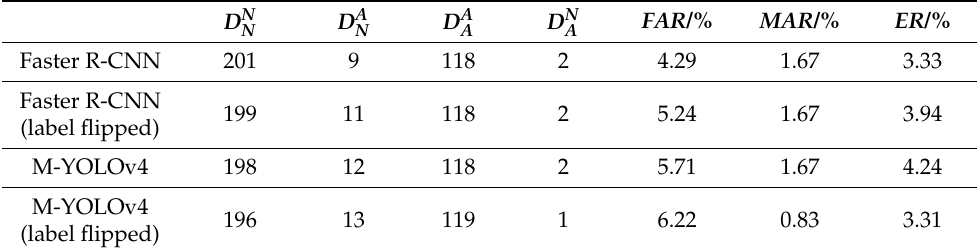
Table 2. Comparison of results after adding noise.